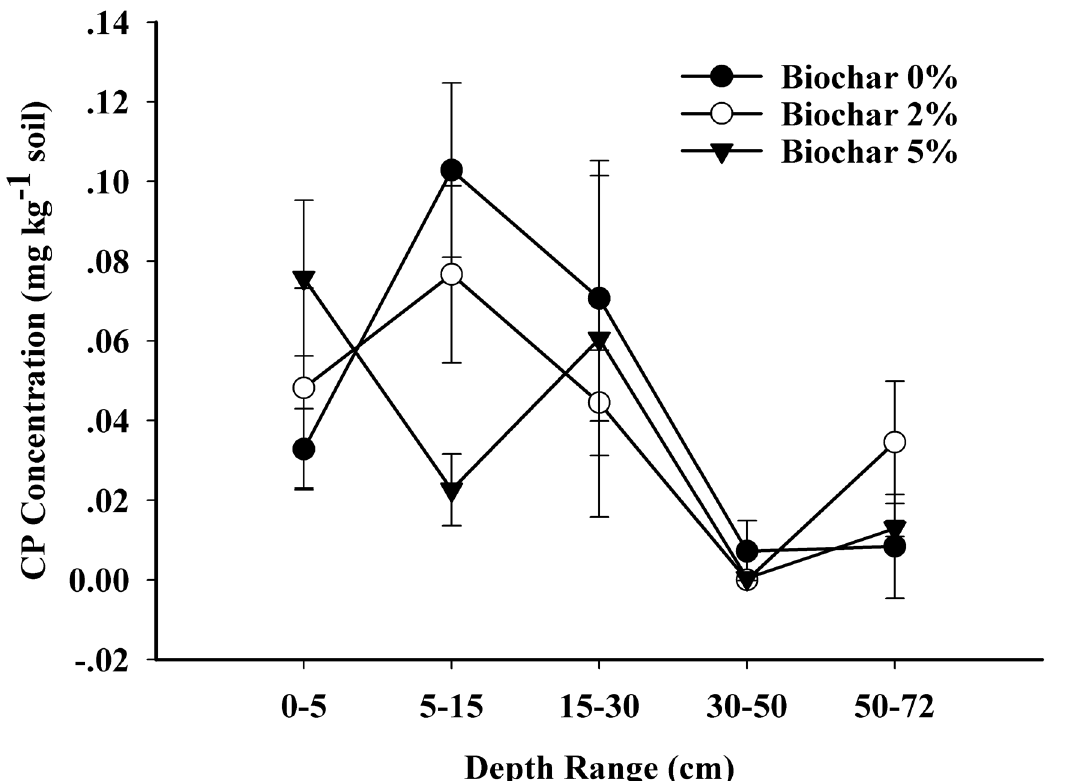
Fig 5. Residue of CP in soil in soil column treatments.